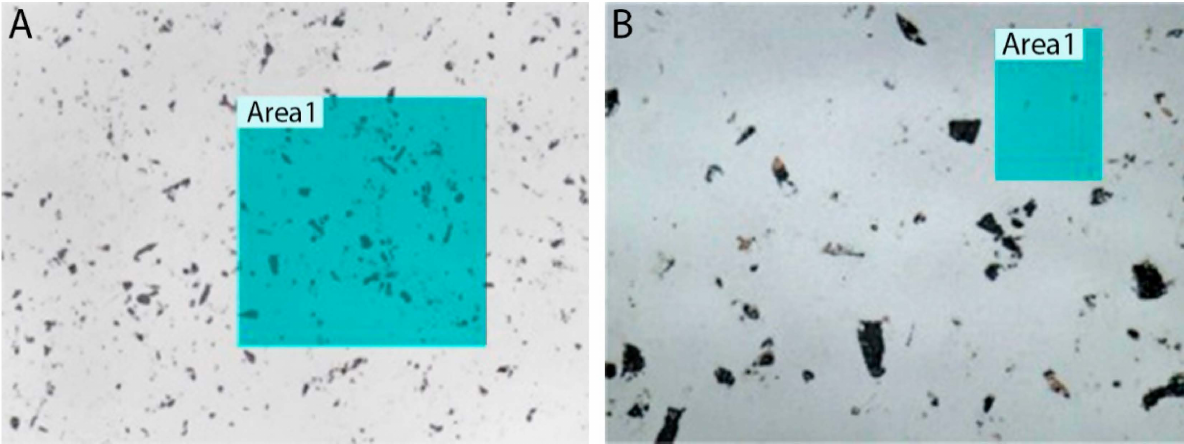
Figure 2. In-surface roughness (laser + optical microscope): ( A ) surface with larger unevenness ( × 50); ( B ) surface with small unevenness ( × 150). Adapted from [15] with kind permission of Brno University of